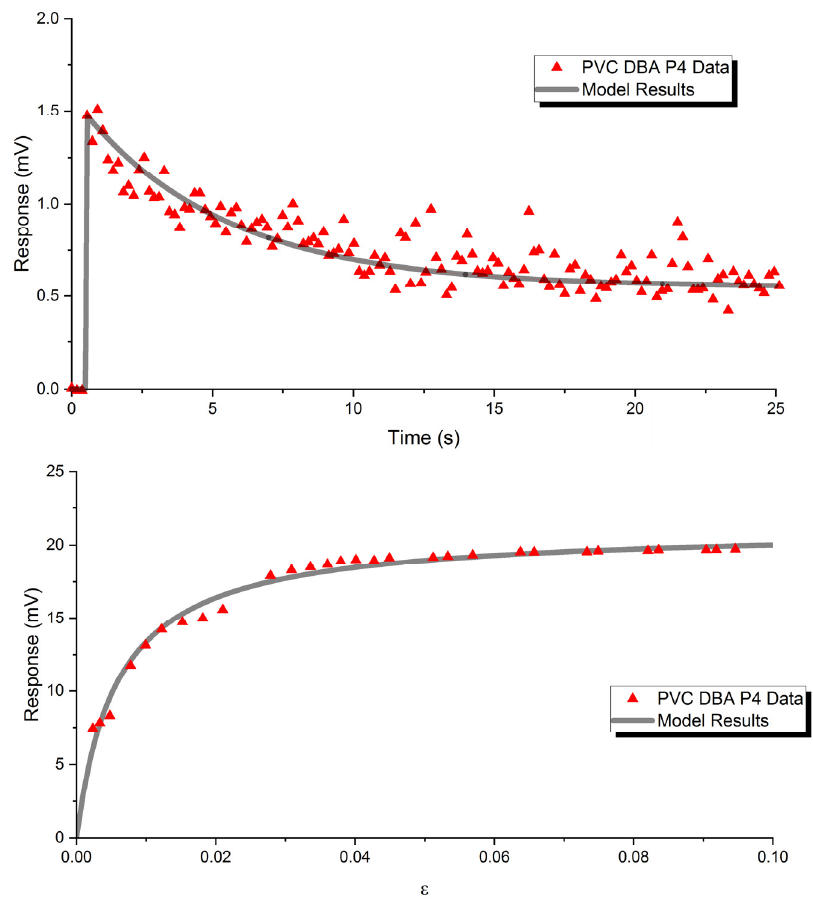
Figure 12. Obtained experimental data and mathematical model results for transient ( top ) steady- state ( bottom ) response characteristics showing ability of the model to reflect experimental results of soft polymer gel sensors.